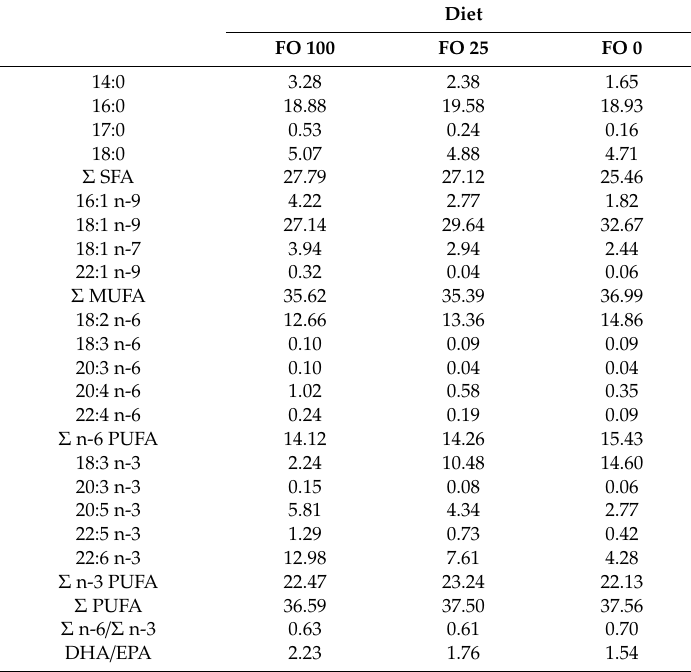
Table 2. Fatty acid composition (% of total fatty acid content) of the experimental diets.